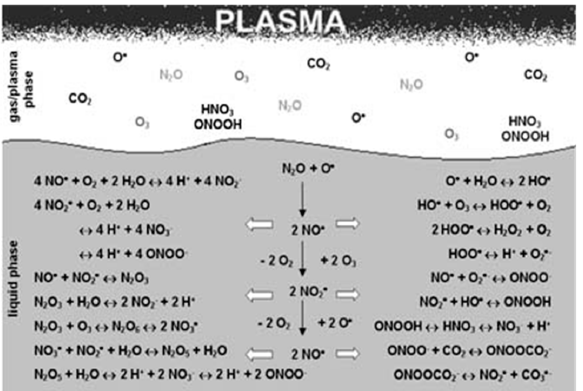
Figure 3. Possible reaction channels of plasma/gas–liquid interactions. With permission from Ref.